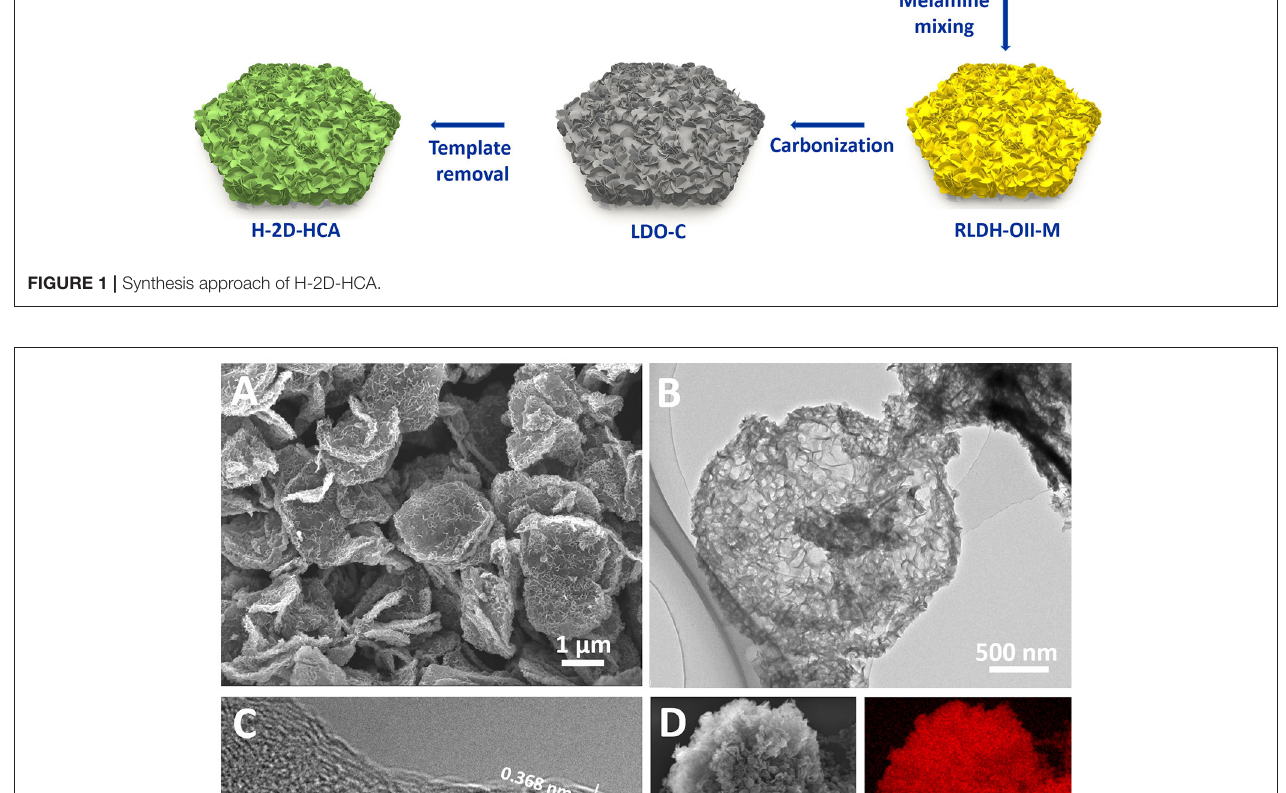
(164.8 eV) and SO X group (167.7 eV) ( Figure 3C ; Zhang